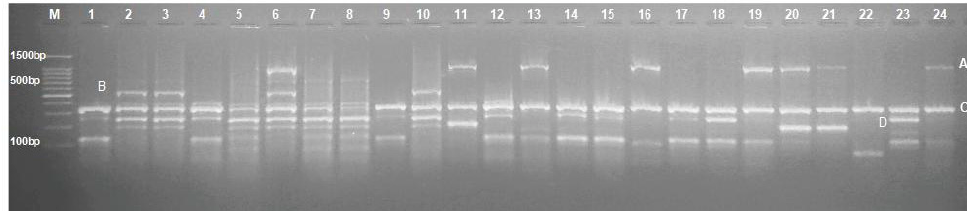
Figure 2. Multiplex PCR identification of OXA carbapenemase gene families in A. baumannii under investigation. A, B, C, and D mark for bla OXA-23 (1058 bp), bla OXA-58 (599 bp), bla OXA-51 (353 bp), and bla OXA-24 (246 bp) fragments, respectively. (M) indicates 100 bp Marker from Genetex, A. baumannii strains in the study from lane 1 to 23, and lane 24 represent bla OXA-23 positive control strain.